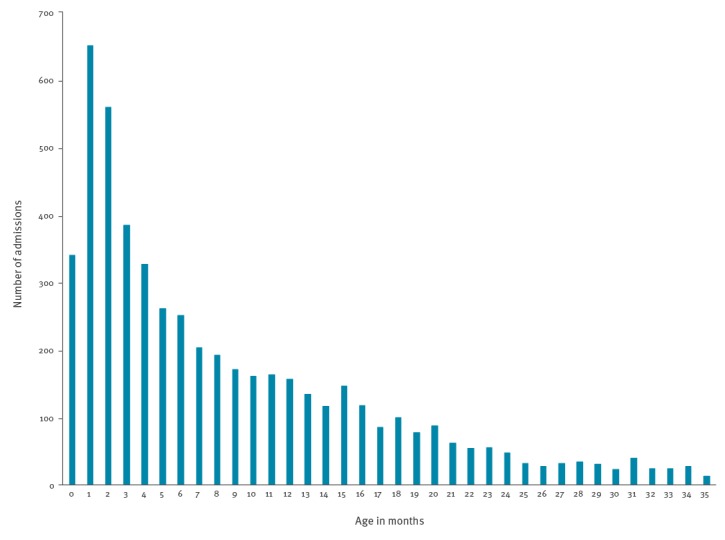
Distribution of respiratory syncytial virus hospital admissions by month of age in children less than 3 years old, birth cohort study, Scotland, 2009–2015 (n = 5,185)